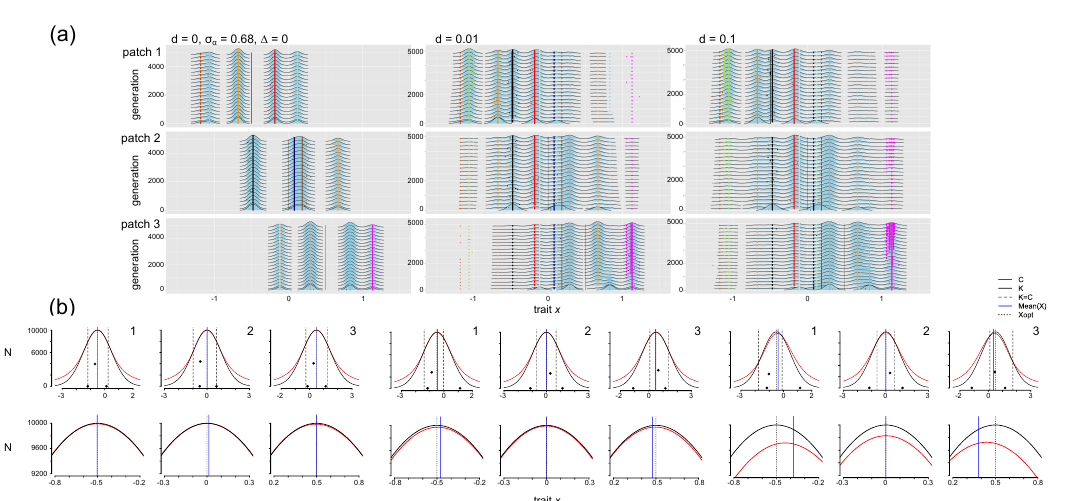
Figure 2. Trait evolution and competition for multiple species in communities over time in an unchanging environment ( ∆ = 0, σ α = 0.68, d = 0, 0.01, and 0.1). ( a ) Time series of phenotypic distributions. Density plots of trait values ( x axis) weighted by relative abundance (height of density curve; populations with a frequency below 0.01 are not shown) are shown over 5000 generations ( y axis; the time series was thinned for visualization, so density plots along the y axis are shown every 250 generations), with a colored point indicating the species identity of lineages in each generation (each species is assigned a unique color). Simulations were run for 50,000 generations but the dynamics are clear within the first 5000 generations. The solid black line in each plot indicates the local optimal trait value. These density plots show the kernel density estimate of trait values across all individuals in the patch within a generation. Each population with a unique trait value is shown as a point, colored by species identity (drawn using the R package ‘ggplot2’ and ‘ggridges’, with a relative minimum height of 0.01 [43,44]). ( b ) Competition strength and carrying capacity as a function of trait value for d = 0, 0.01, and 0.1 (left to right) in three patches (left to right are patch 1–3). Plots on the top row show competition ( C ( x ), red, Equation (3)) and carrying capacity ( K ( x ), black, Equation (1)) as a function of trait value x ( x axis) and are calculated as average values from 121 sampled generations spaced evenly from generation 20,000 to 50,000. Black points show the phenotypic distribution in each patch and their corresponding population size ( y axis). The left and right-most points are the average trait values (across the 121 generations considered from time 20,000 to 50,000) of the species with the lowest and highest trait values and the middle point is the average trait value of the species with the highest population size. The patch’s x opt (short-dashed black line), the community’s mean x (blue solid line, averaged across the sampled 121 time points, weighted by population size), and points where the carrying capacity and impact of competition are equal to one another (long-dashed black line) are shown as well. The plots on the bottom row are zoomed in to better see distinctions between the C ( x ) and K ( x )